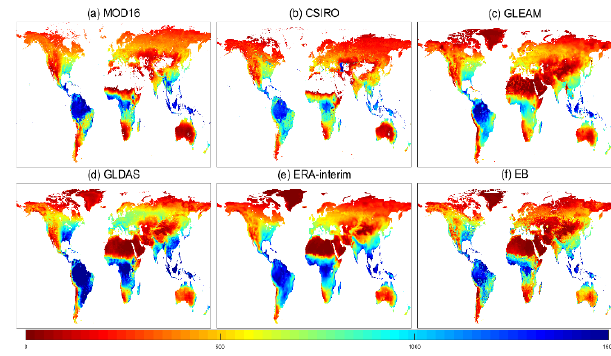
Table 2: ET algorithms comparison